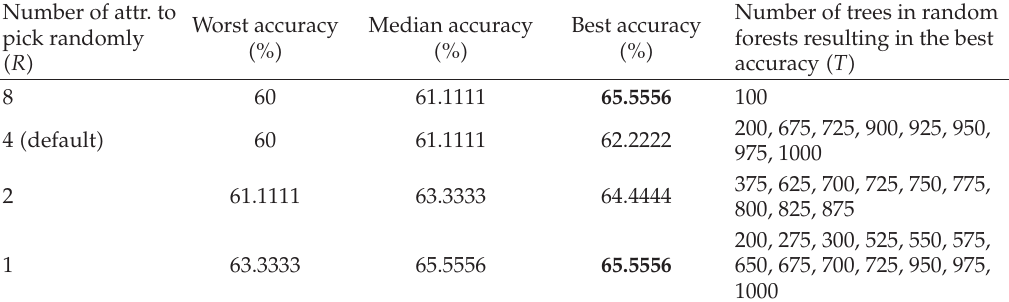
Table 10: The accuracy of random forests for the data set “Post